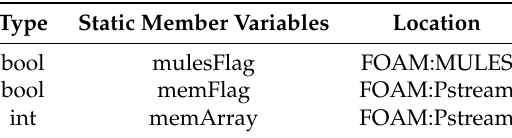
Table 4. Added static member